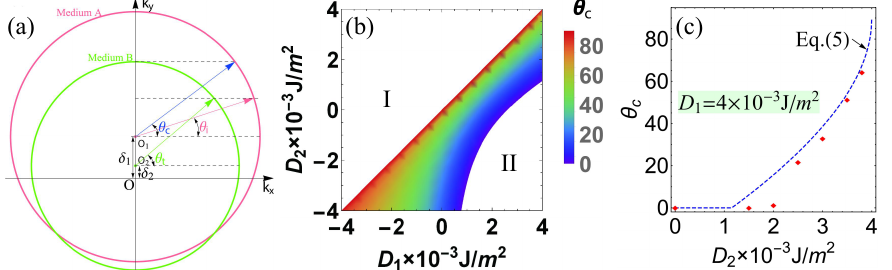
Figure 2. ( a ) Schematic illustrations of reflection and refraction of spin-wave at an interface between two different media in wave vector ( k x − k y ) space. The pink and green circles indicate the individual frequency contours of the allowed modes in the same-color-coded media A and B, respectively. The color-coded arrows denote the spin-wave vectors k propagating in each medium, as indicated by the incident (pink) and refracted (green) rays. The blue arrow denotes the critical angle. ( b ) Phase diagrams of critical angle θ C in the D 1 − D 2 plane. No TIR exists in the white regions. ( c ) Critical angle θ c as a function of DMI constants D 2 with a fixed DMI constant D 1 = 4 × 10 − 3 J/m 2 . The symbols (red squares) are simulation data, and the solid curve represents the analytical results of Equation